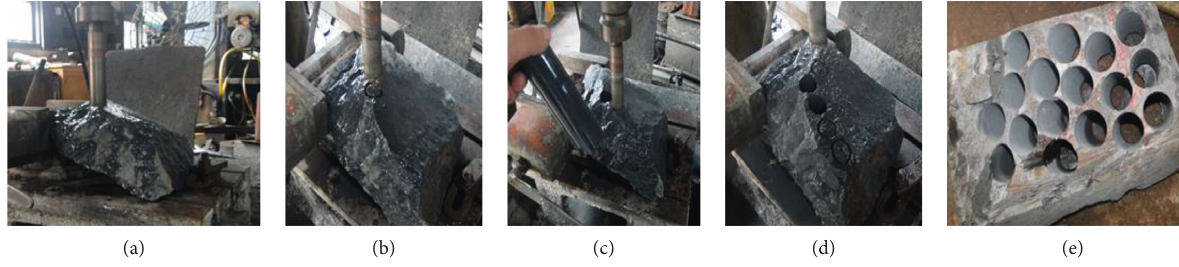
Figure 3: The preparation of specimens.